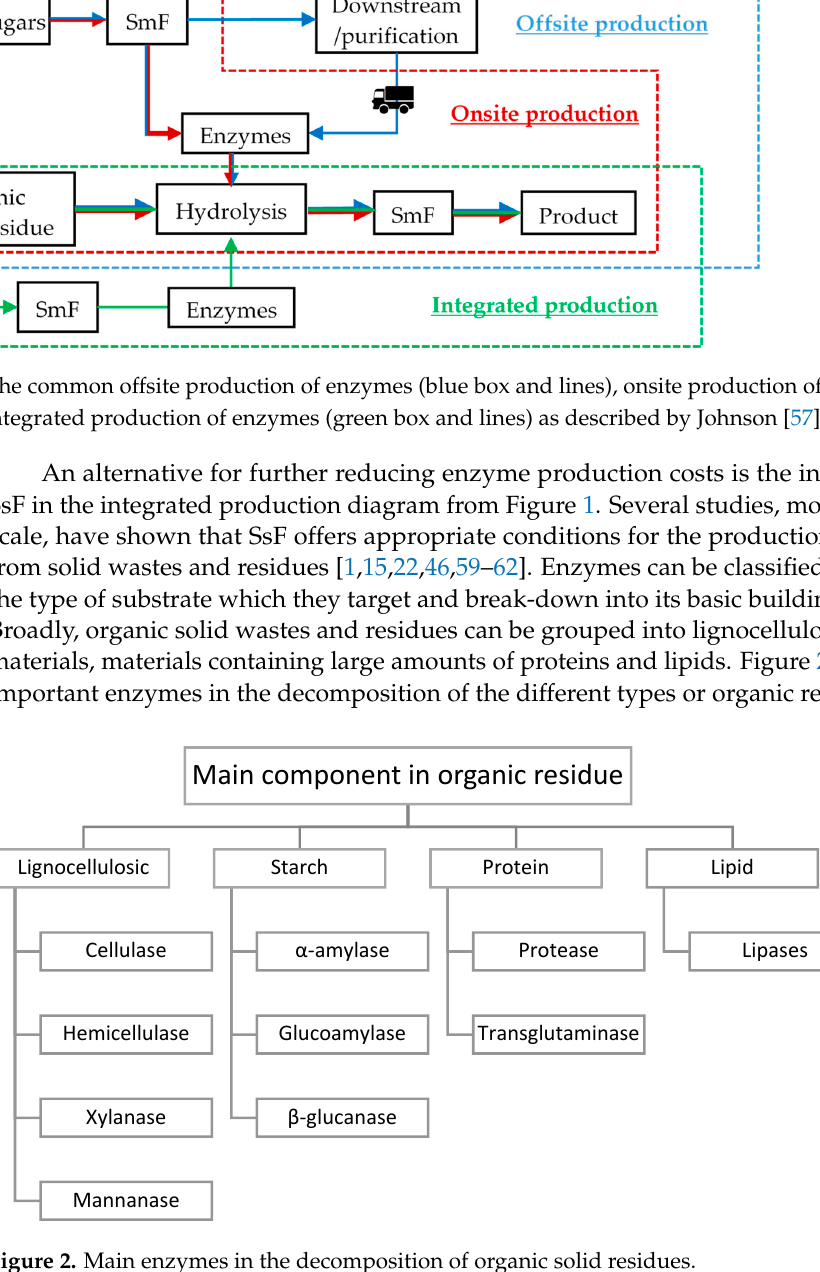
Figure 2. Main enzymes in the decomposition of organic solid residues.